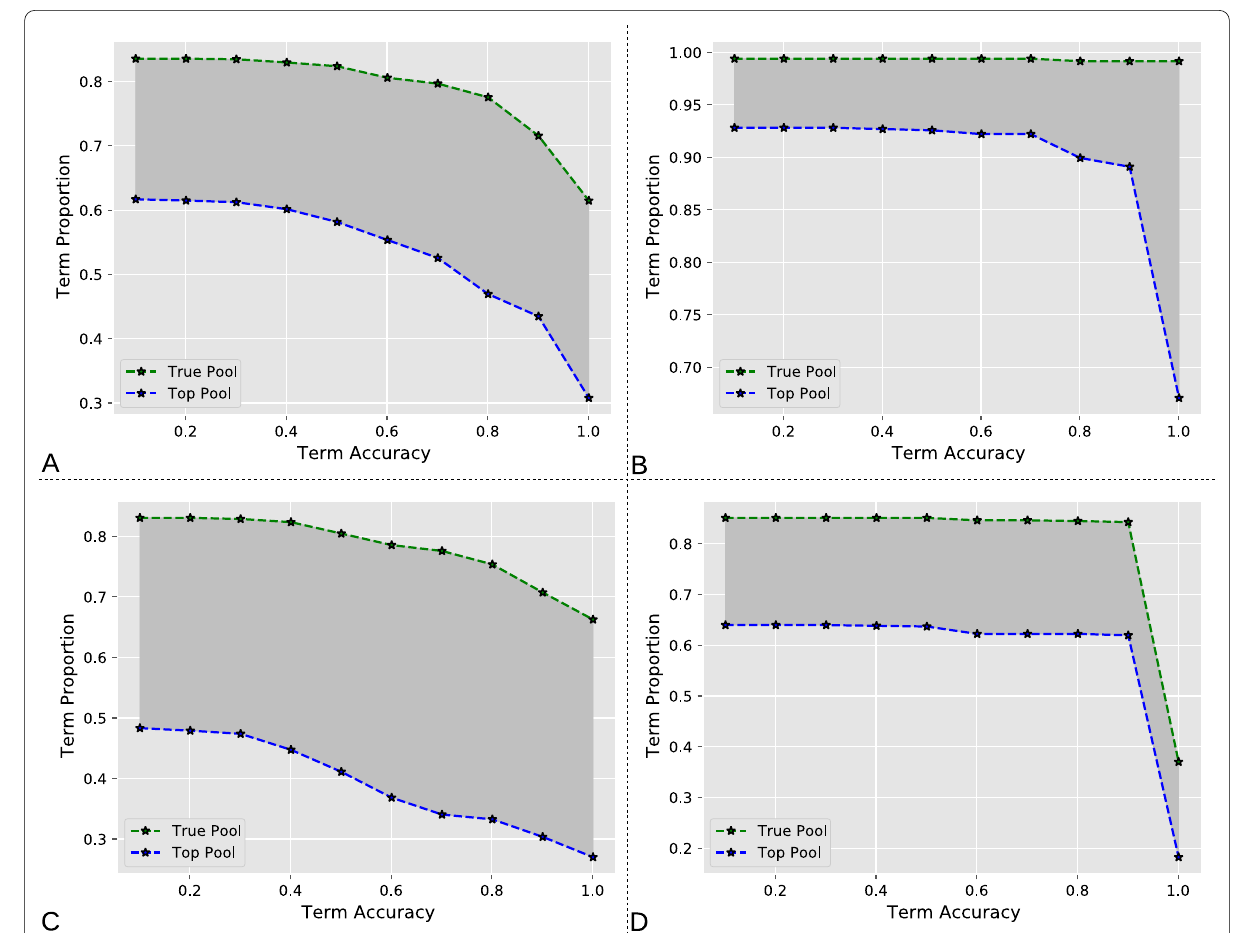
Fig. 7 Labor automation analysis. A Fraction of labels identified by the metadata extraction system across all metadata categories as a function of identification accuracy. The green curves represent all suggested terms regardless of rank (True Pool), while the blue curves represented the recommended terms only if they appear at the highest rank (Top Pool). Same analysis broken down by species ( B ), brain region ( C ), and experimental condition ( D